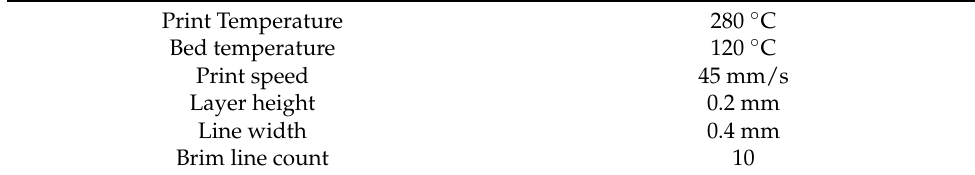
Table 2. Print settings for Ultimaker© printing PC.